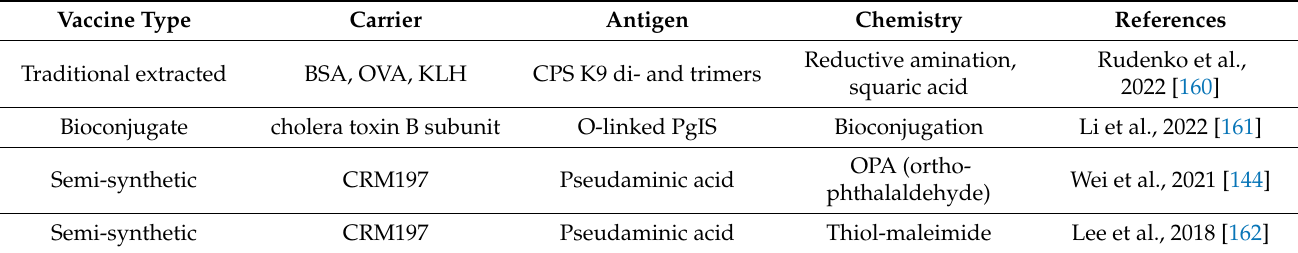
Table 11. Carbohydrate conjugate vaccines targeting Acinetobacter baumanii